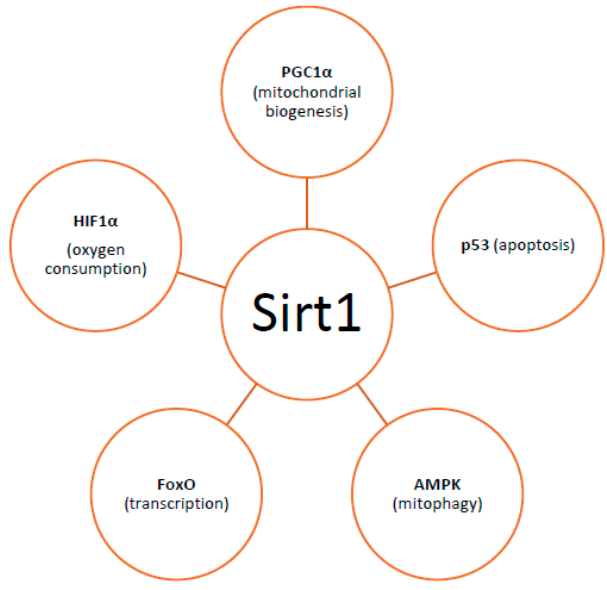
Figure 1. The level of mitochondrial DNA damage determines whether mitophagy or cell death will be stimulated. ATM (ATM serine/threonine kinase), p53 and Sirt1 (sirtuin 1) mediate the signaling between the nucleus and the mitochondria.